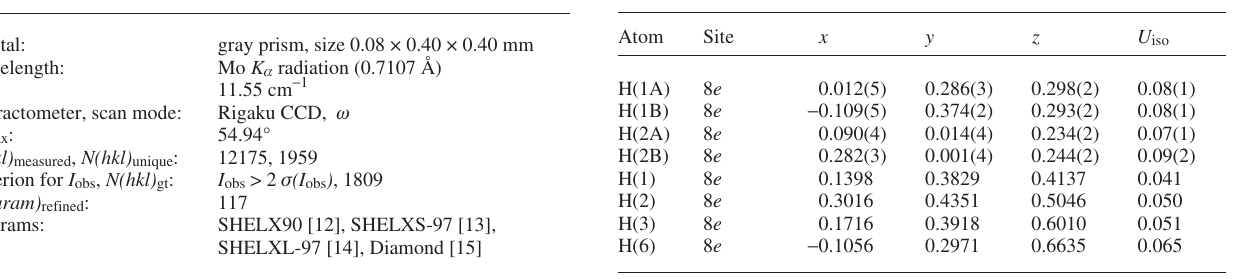
Table 2. Atomic coordinates and displacement parameters (in Å 2 ) . Table 1. Data collection and